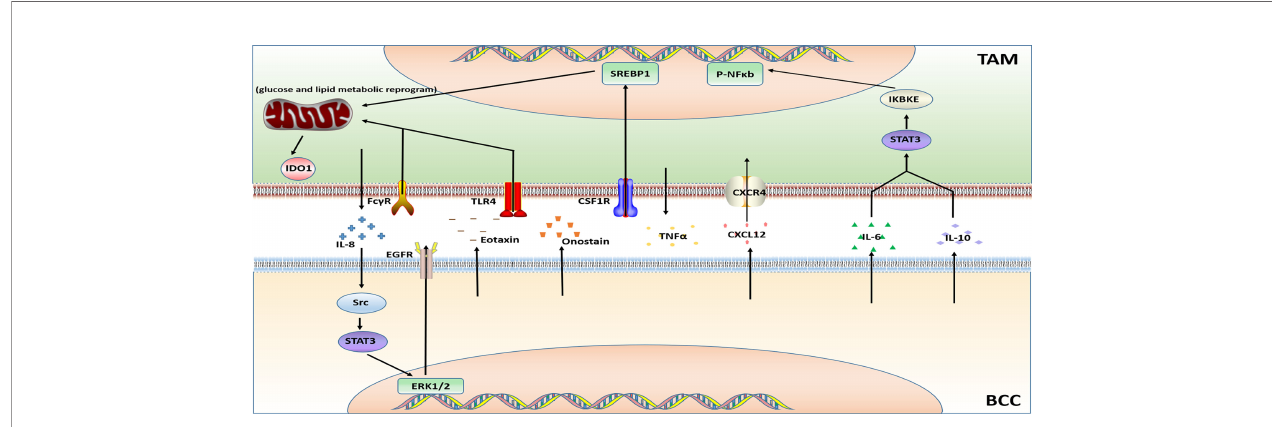
FIGURE 4 | Major mechanisms of targeted therapy resistance in BC in connection with